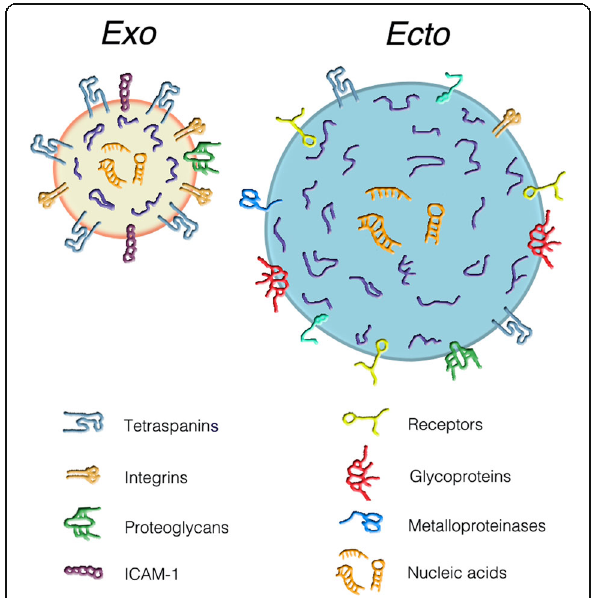
Fig. 1 The two types of EVs: exosomes (left) and ectosomes (right). The figure shows the two types of EVs. In terms of size the exosomes (gold content) are smaller (diameters of 50 – 150 nm) while the ectosomes (sky-blue content) are larger (diameter of 150 – 500 nm). In terms of composition the membranes of exosomes are rich in tetraspanins, a protein complex highly important for the distribution of other proteins including those trapped at the luminal surface. A lower density of tetraspanins is present in the membrane of ectosomes. A similar partial difference is true for integrins and proteoglycans. In contrast, the adhesion molecule 1 (ICAM-1), is appreciable only in the exosome membrane. The ectosome membrane is rich in other proteins: receptors, glycoproteins, metalloproteinases and others. Among the EV membrane proteins, some of the cytosol establish specific binding with surface receptors of target cells, a process necessary for the subsequent EV uptake. The lumenal cargos are similar in the two EV types. They contain many typical proteins (blue strings), some of which anchored to the EV membrane, mixed with low concentrations of cytosolic proteins. The lumena of both EVs show various types of orange sequences composed by nucleic acids, i.e. the coding mRNAs, the non-coding miRNAs and cicrRNAs and, in some cases, also DNA sequences. Reproduced with permission from Fig. 2 of Ref.